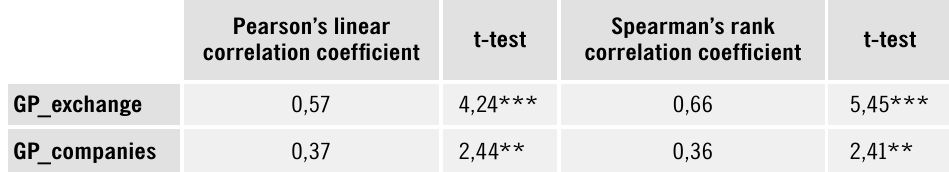
Table A4.1. Values of correlation coefficients between alternative SDI and GP _ exchange and GP _ companies